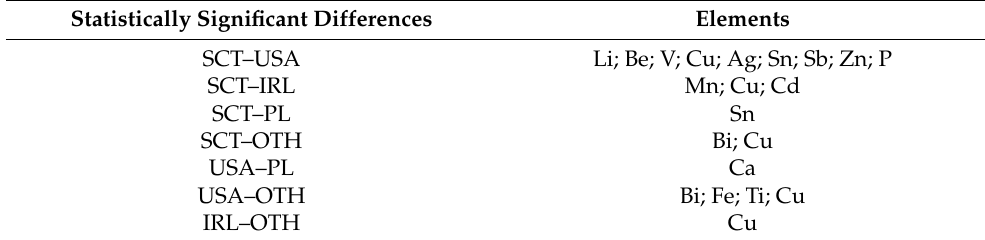
Table 3. Groups for which statistically significant differences were